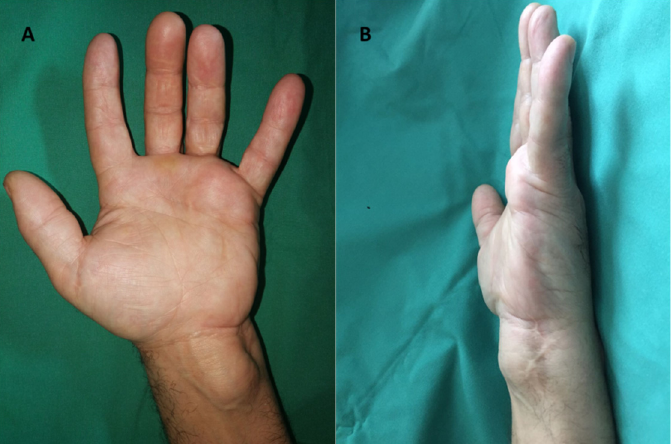
Figure 2. Giant lipoma in the midpalmar region and spontaneous rupture of the superficial and deep flexor tendons of the 5th finger: ( A ) palmar aspect and ( B ) lateral aspect.